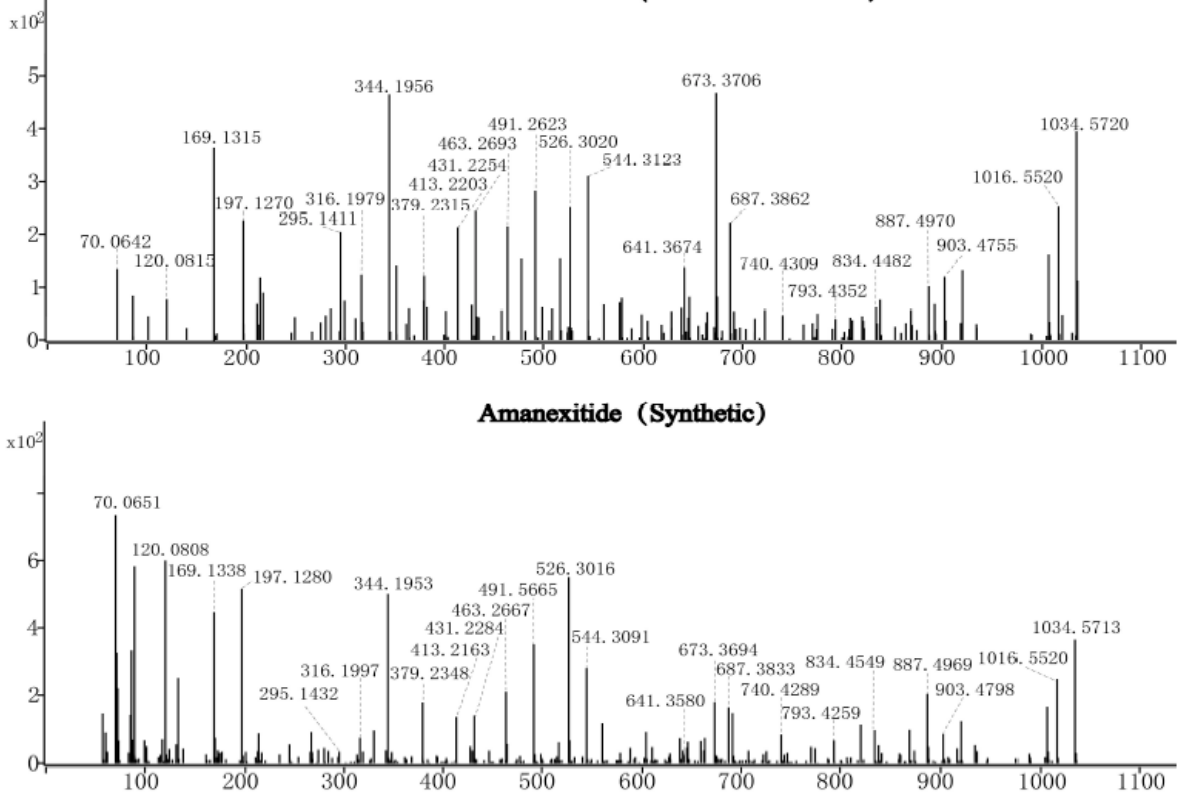
Figure 4. MS/MS fragment comparison of three natural and synthetic cyclic peptides from Amanita species. Fragment ions of natural and synthetic CylG1 ( A ), CylG2 ( B ), and amanexitide ( C ). CylG1 and CylG2 are produced by A. subjunquillea , and amanexitide is produced by A. exitialis . Shared ions are labeled.